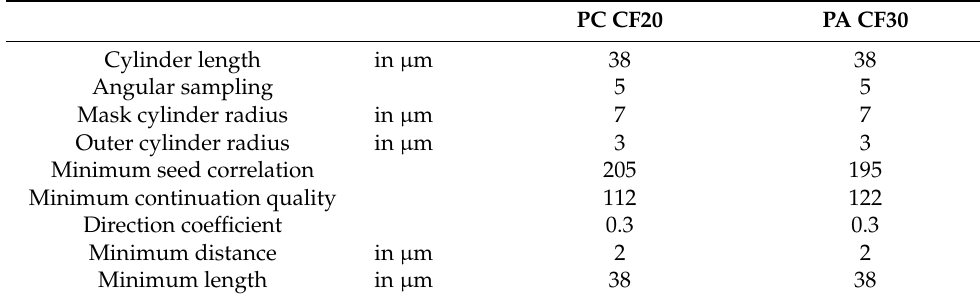
Table 4. XFiber extension settings (Avizo